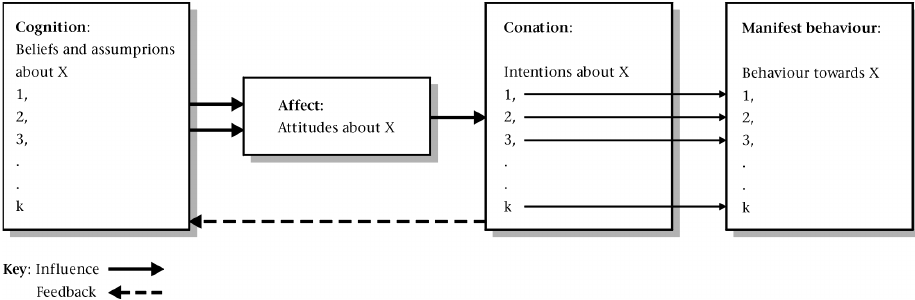
Figure 2: The link between cognition, affect, conation and manifest behaviour (adapted from Fishbein & Ajzen,